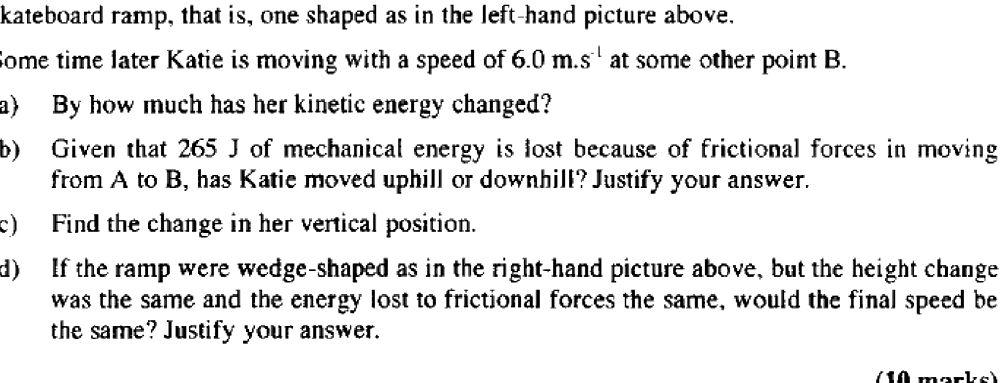
FIG. 2. Two of the 12 questions in the examination paper. Question 4 is a conceptual question, whereas question 10 is a more traditional